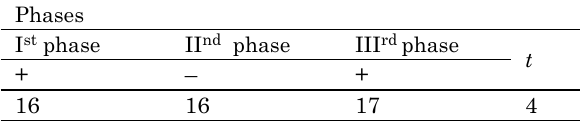
table 2. temporal length of the phases Phases